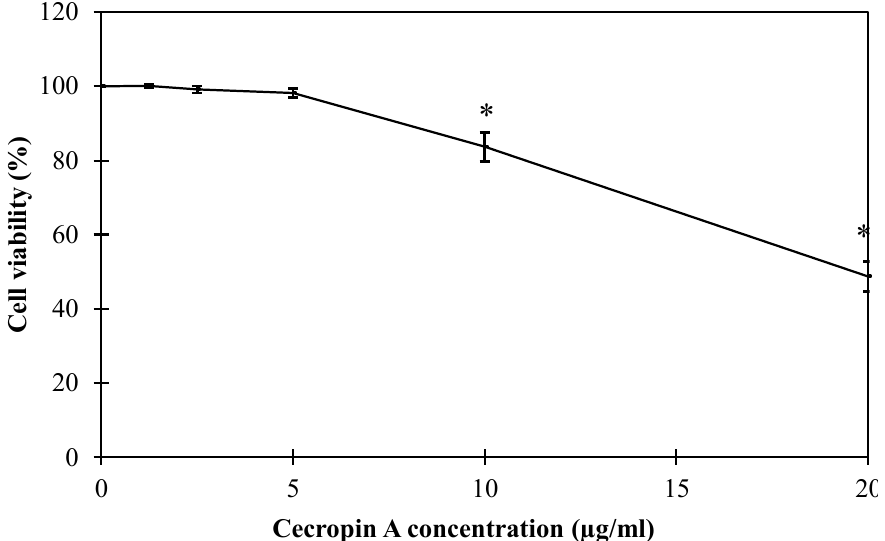
Figure 8. Change of cell viability of oral epithelial cell line treated with different cecropin A concentrations. The maintained cell line was treated with different cecropin A concentration (0–20 µg/mL) for 72 h. The treated cells were then fixed using 10% TCA and treated with SRB for 10 min for assessing cell viability spectrophotometrically at 540 nm. Each value represents the mean ± standard deviation from three independent replicates. Asterisks represent the statistical differences from the values for 10 mM tris buffer pH 7.5-treated cells (Student’s t test; * p < 0.05).